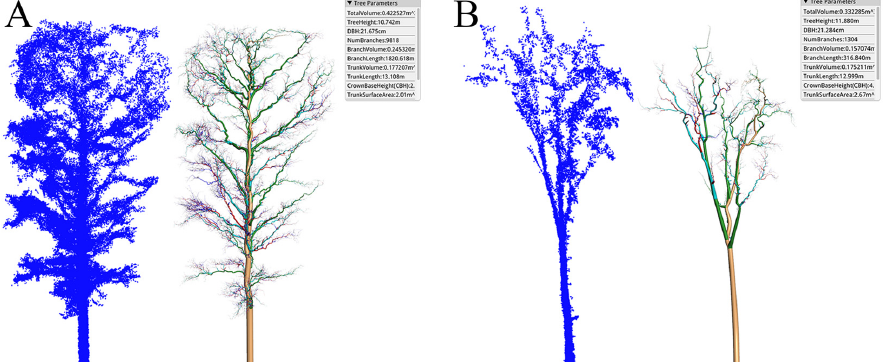
Figure 6. ( A ) 3D structural model of Larix gmelinii individual tree point cloud data and AdQSM reconstruction, and ( B ) 3D structural model of Betula platyphylla individual tree point cloud data and AdQSM reconstruction.